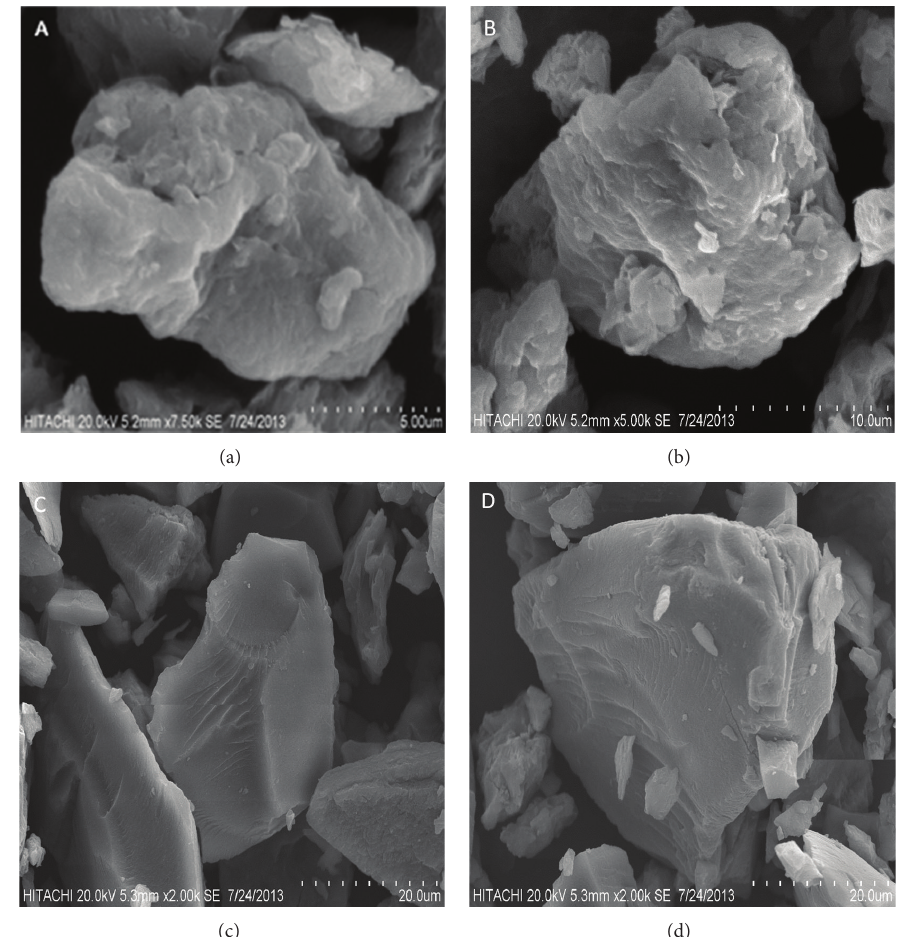
Figure 6: Field emission scanning electron micrographs of Tween-LDH ((a) and (b)), and of the tween-dopa-LDH nanocomposite ((c) and (d)).